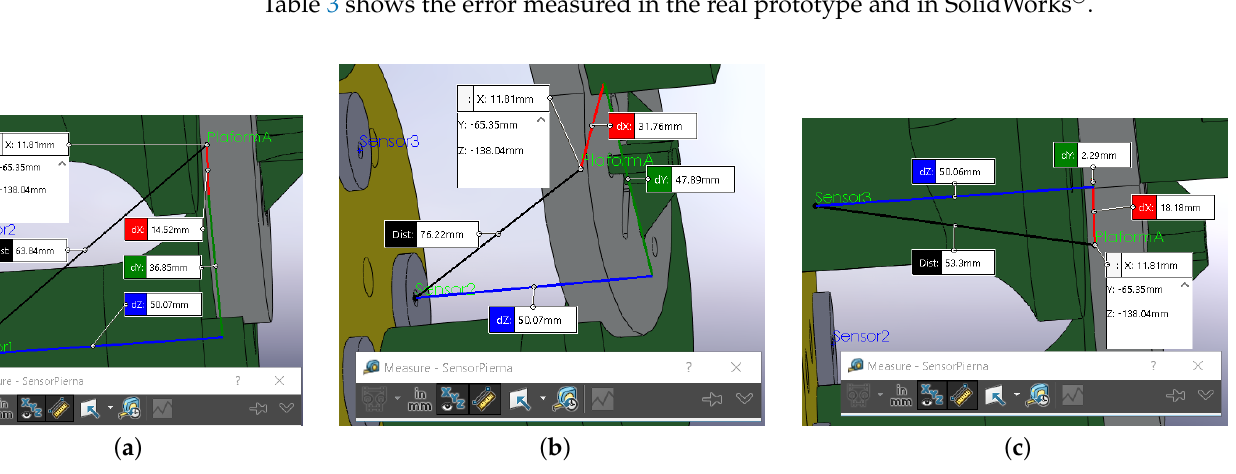
Figure 33. Measuring in SolidWorks (2017–2018 Student Edition, Dassault Systèmes, Vélizy- Villacoublay, France) ® : ( a ) sensor 1, ( b ) sensor 2, ( c ) sensor